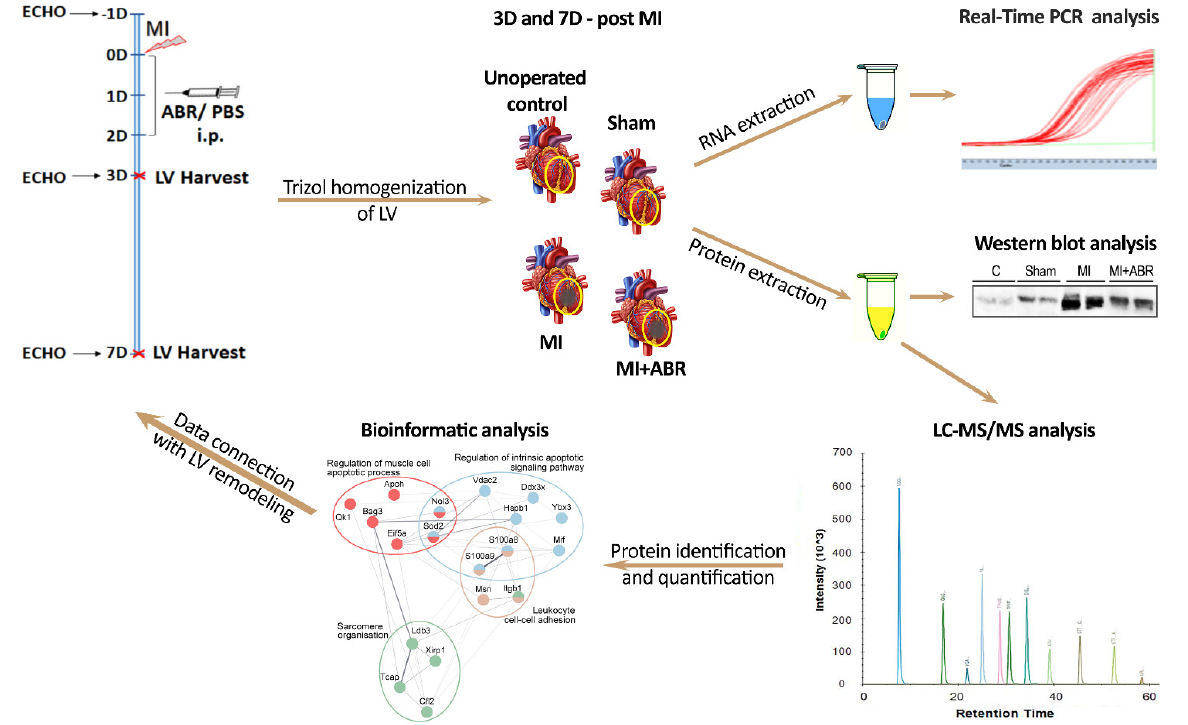
Figure 8. Schematic diagram of the experimental design. Mice were subjected to myocardial infarction (MI) by permanent left coronary artery ligation. The S100A9 inhibitor ABR-238901 (ABR, 30mg/kg diluted in PBS) or PBS were administered intraperitoneally (i.p.) immediately (0D), at 1 day (1D) and at 2 days (2D) after MI. Echocardiography (ECHO) was performed one day before MI (1D) and at 3 (3D) and 7 days (7D) after MI. The left ventricle of control mice (unoperated and Sham) and mice with induced infarction (MI and MI + ABR) were harvested from the indicated area (yellow circles) at 3 days and 7 days post-MI and homogenized with TRIzol Reagent for RNA and protein isolation. The RNA samples were analyzed by real-time PCR assays. The protein samples were analyzed by Western blot and LC-MS/MS, followed by bioinformatic analysis.